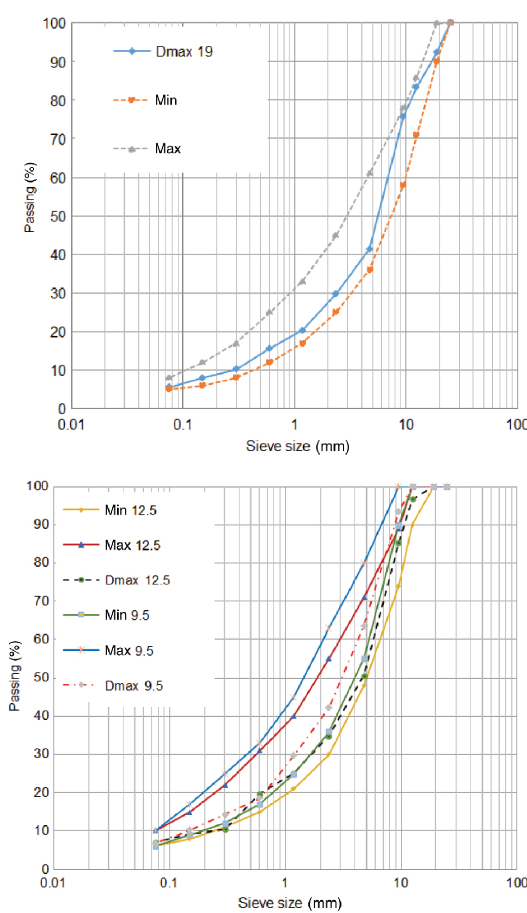
Figure 4: Grading curve graph.